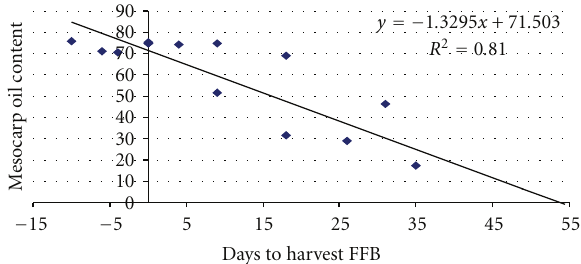
Figure 8: The model of the harvesting days for FFB 20-year-old oil palm tree.